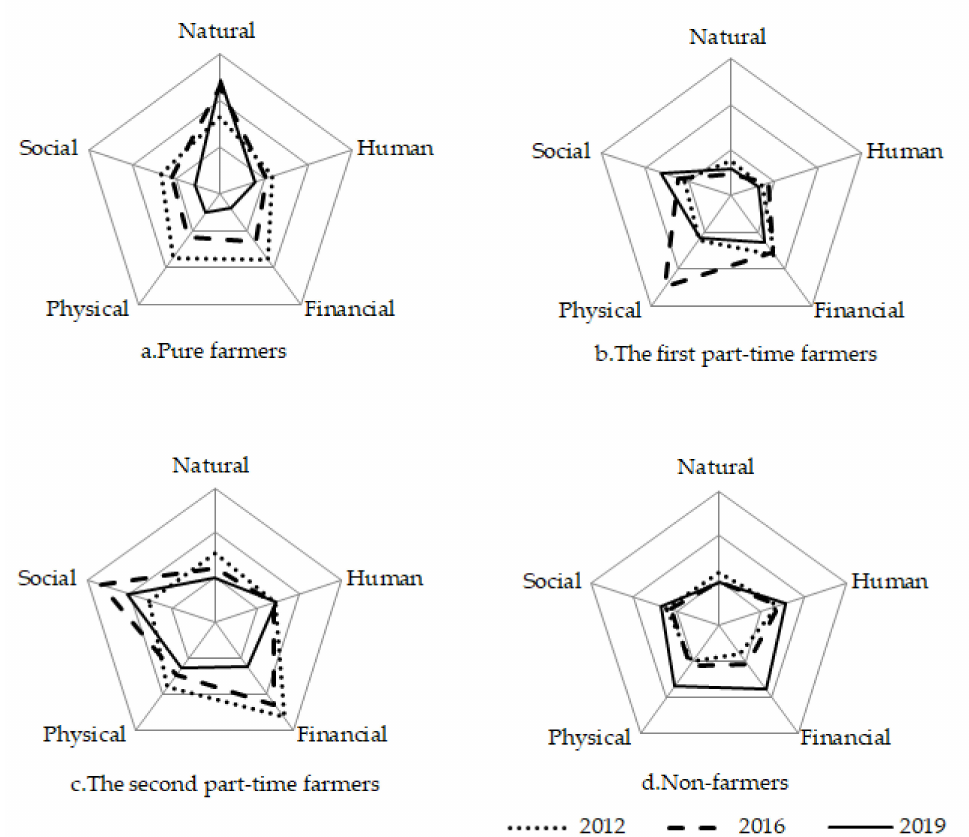
Figure 2. Changes in livelihood capital allocation of different types of farmer households. Note: ( a ) Table 3. ( b ) The maximum value of the coordinate axes in ( a – d ) is 0.15, the scale unit is 0.05; the maximum value of the coordinate axis in ( b ) is 0.3, the scale unit is 0.1; and the minimum value of the axes of all graphs is